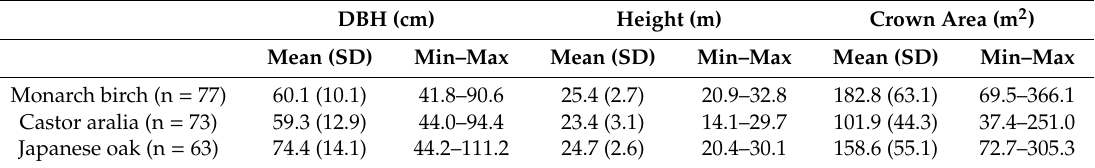
Table 1. Summary of the statistics for field-measured